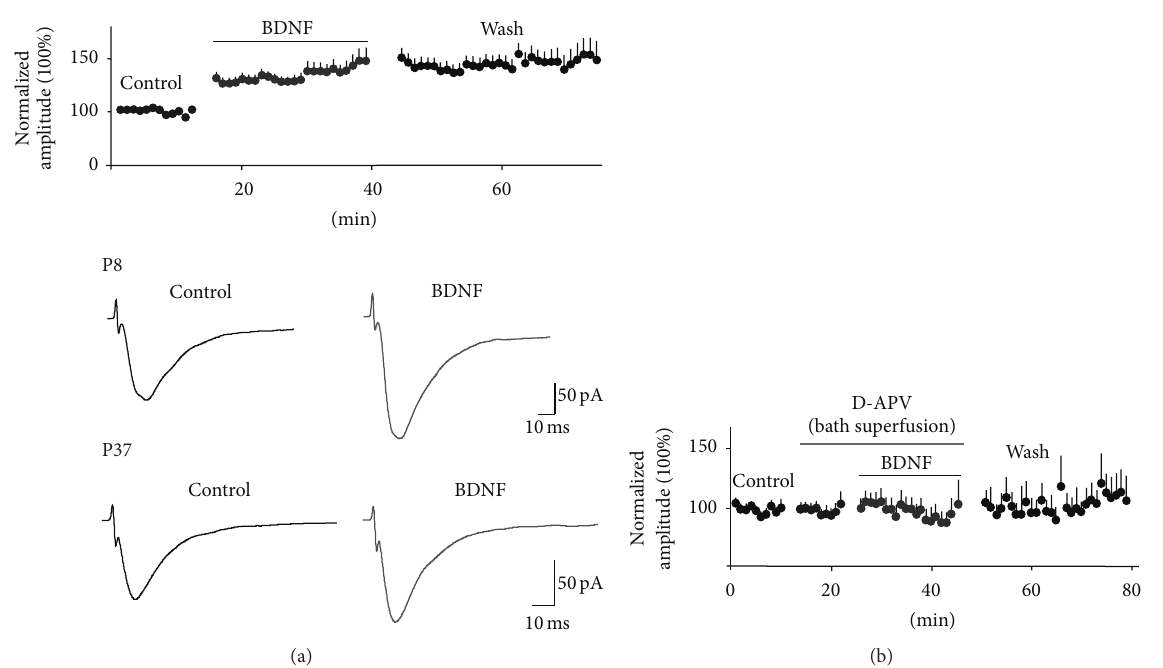
Figure 2: BDNF facilitates synaptic responses. (a) (Top) bath-applied BDNF potentiates dorsal root-evoked synaptic responses in lamina II neurons. In the presence of BDNF, synaptic amplitude is increased by ∼ 30% and remains facilitated during wash. The data represent the average change in synaptic amplitude for all neurons, obtained from animals postnatal days 1–14. The average synaptic amplitude before BDNF application was computed for each neuron and was then normalized to the mean baseline amplitude denoted as 100%. The mean percent change in synaptic amplitude was calculated as the difference between the mean peak amplitude during drug treatment or wash and the mean value of the synaptic responses before drug (control). (a) (Bottom) the average synaptic responses are shown for recordings obtained in P8 and P37 rats before and during BDNF. Note: BDNF-induced facilitation is observed at both ages. (b) Bath application of the NMDA receptor antagonist, D-APV for 10min prior to and during BDNF application blocks BDNF-induced synaptic facilitation ( 𝑛 = 14 ). Data previously reported in Garraway et al. [89,